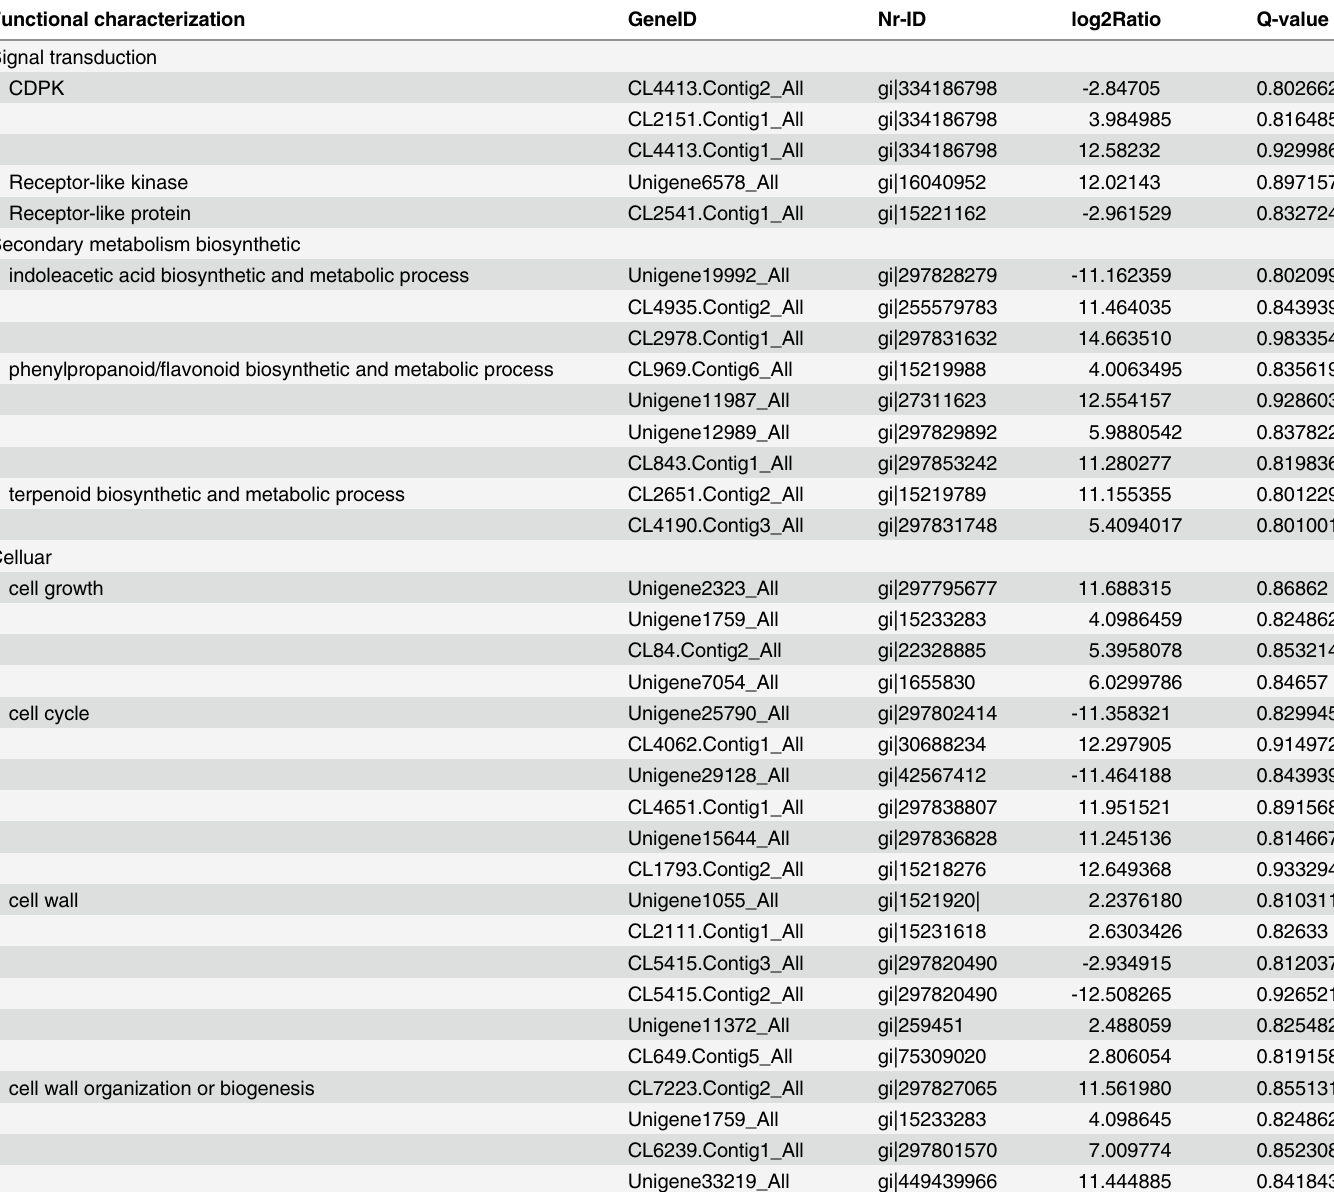
Table 2. Functional classi fi cation of some differentially expressed genes (DEGs) in diploid vs